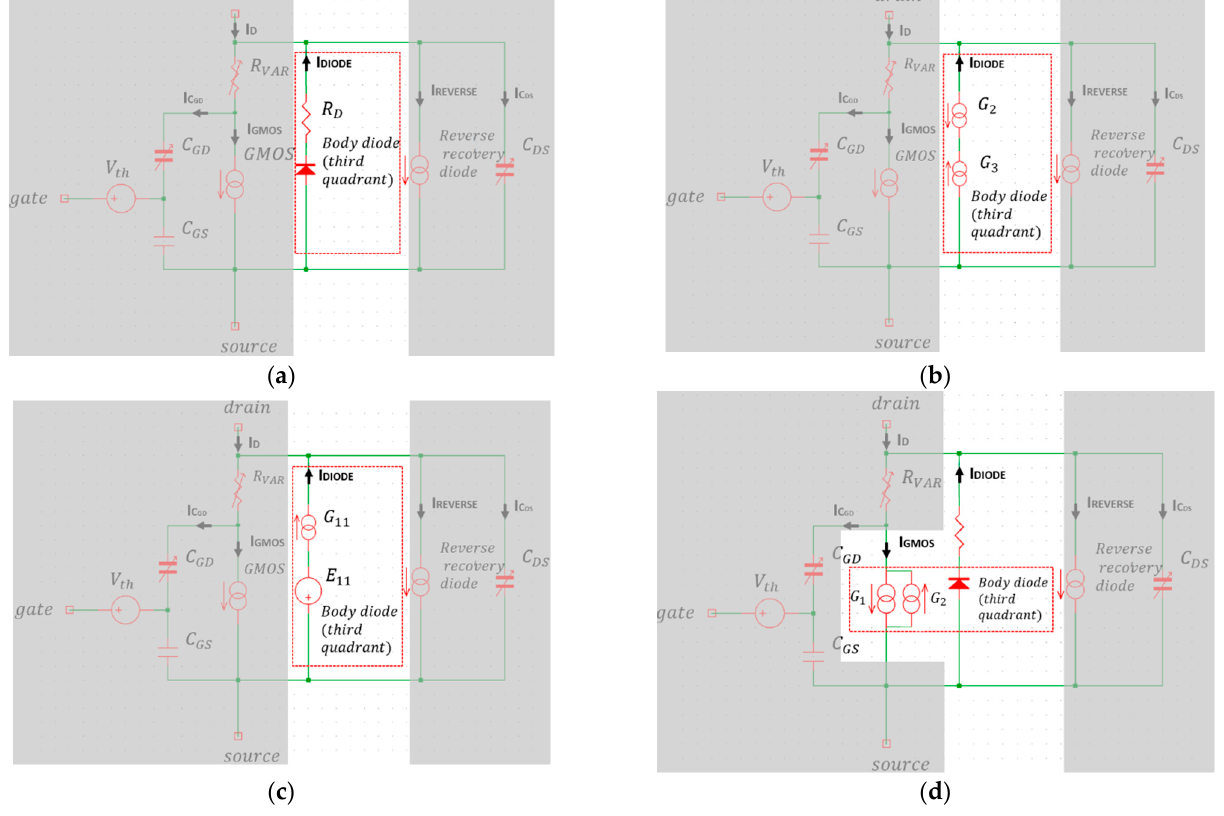
Figure 14. Various body diode and third quadrant implementations: ( a ) body diode; ( b ) STMicroe- lectronics and Cree “C3M” series; ( c ) ROHM; ( d ) Cree “C2M”